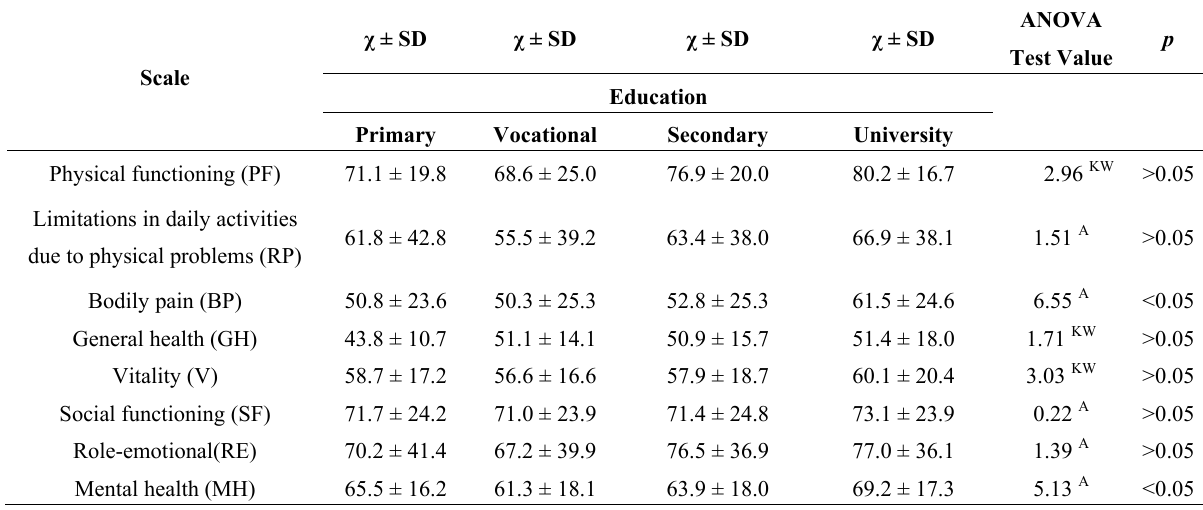
Table 5. Quality of life of respondents according to SF-36 with regard to education and